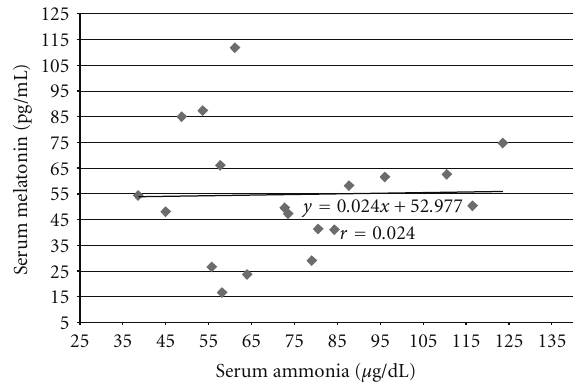
Figure 5: Comparison of melatonin concentration in serum and ascetic fluid in cirrhotic patients with 2nd (group HE 2 , n = 24) and 3rd (group HE 3 , n = 25) degrees of hepatic encephalopathy. ∗∗∗ P < 0 . 001. There are significant di ff erences between mean values obtained in ascitic fluid in groups HE 2 and HE 3 — P < 0 .